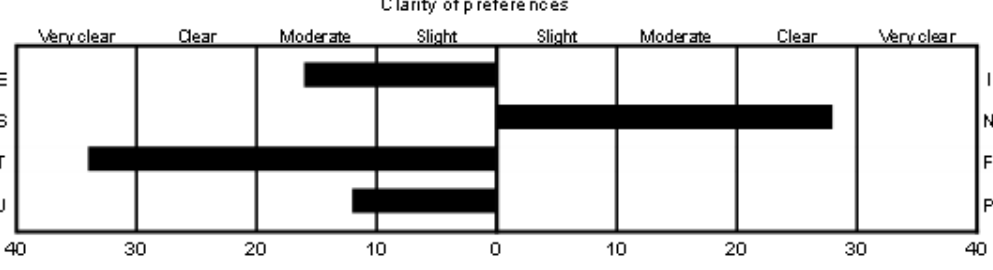
Figure 1. The strengths of MBTI type preferences (Choi, Deek & Im,